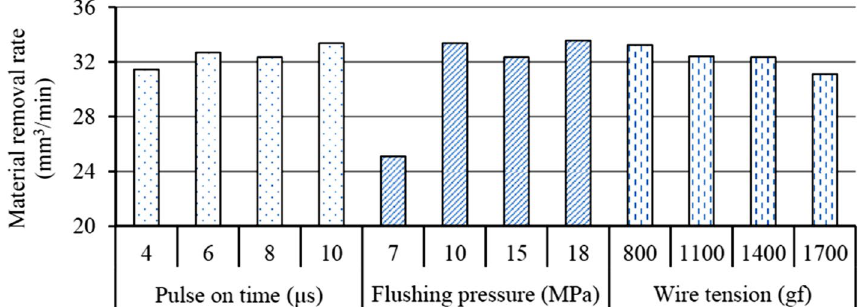
Fig. 6 Influence of pulse on-time, flushing pressure and tension in wire on MRR while WEDM of titanium alloy